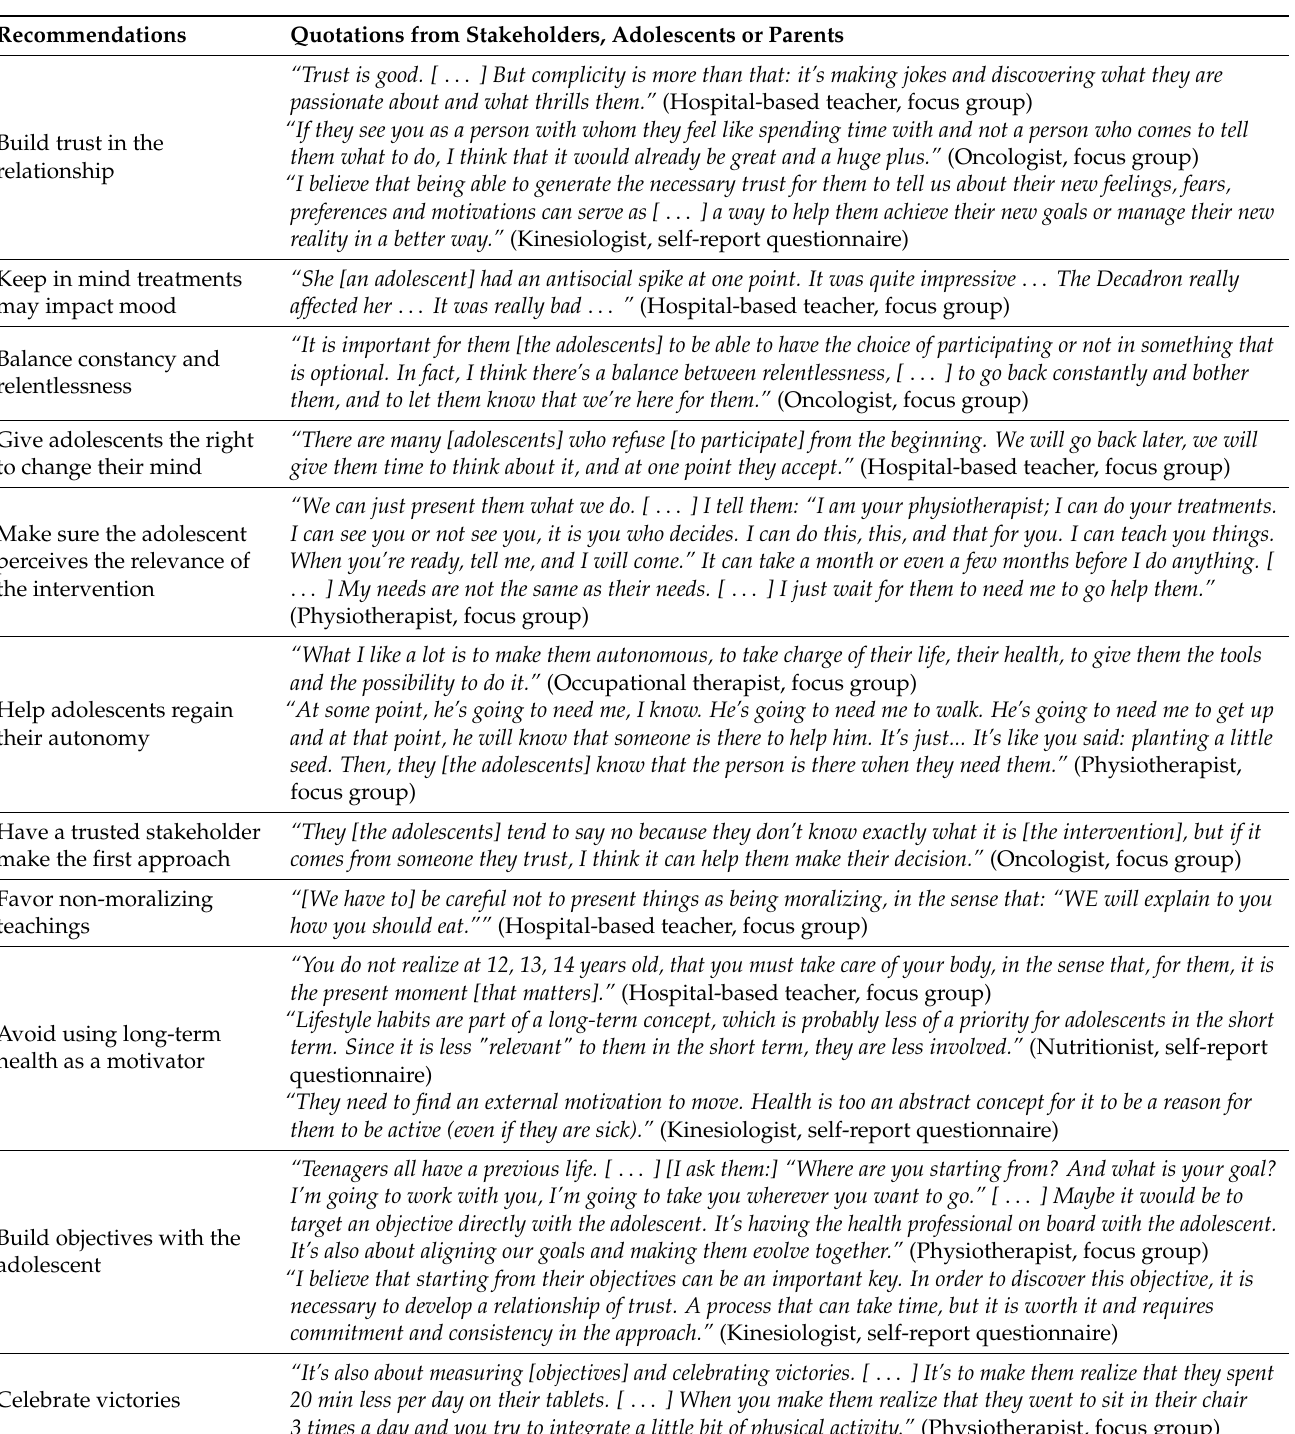
Table 5. Recommendations to adapt oncology lifestyle promotion interventions for